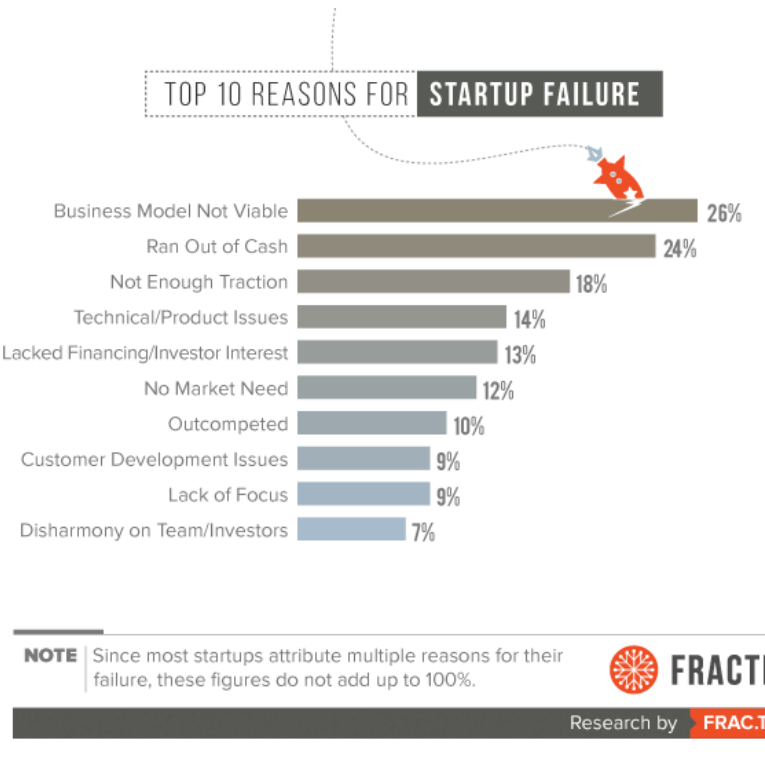
Figure 1. Top 10 failure reasons for start-ups [2], reproduced with